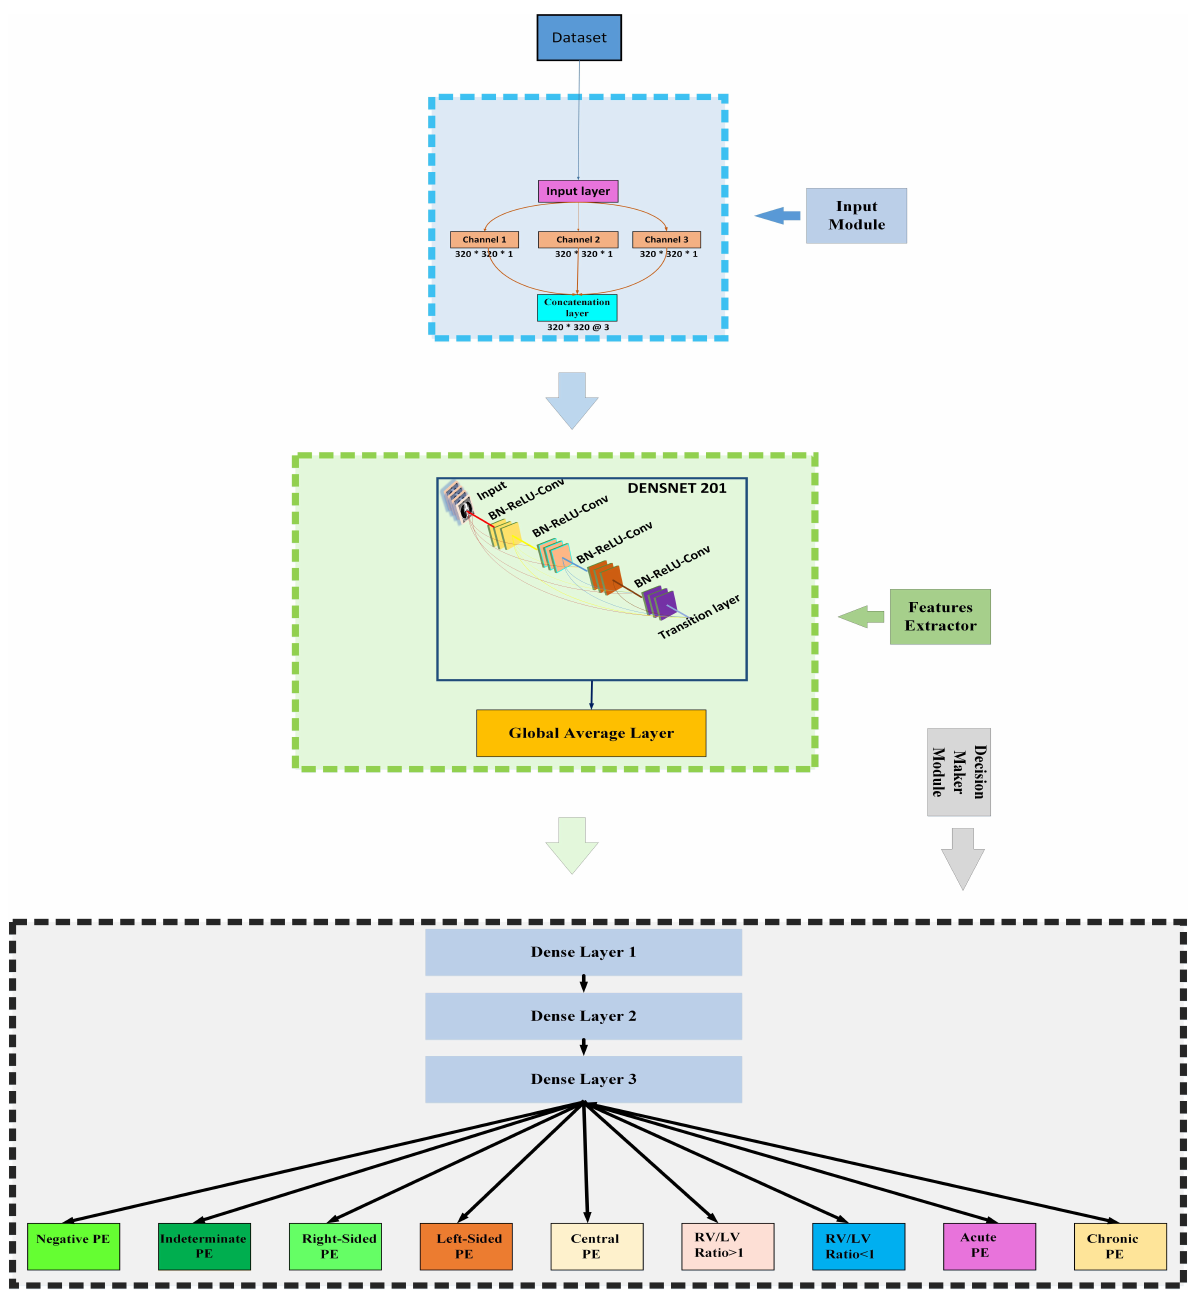
Figure 2. Proposed framework (RV = right ventricle, LV = left